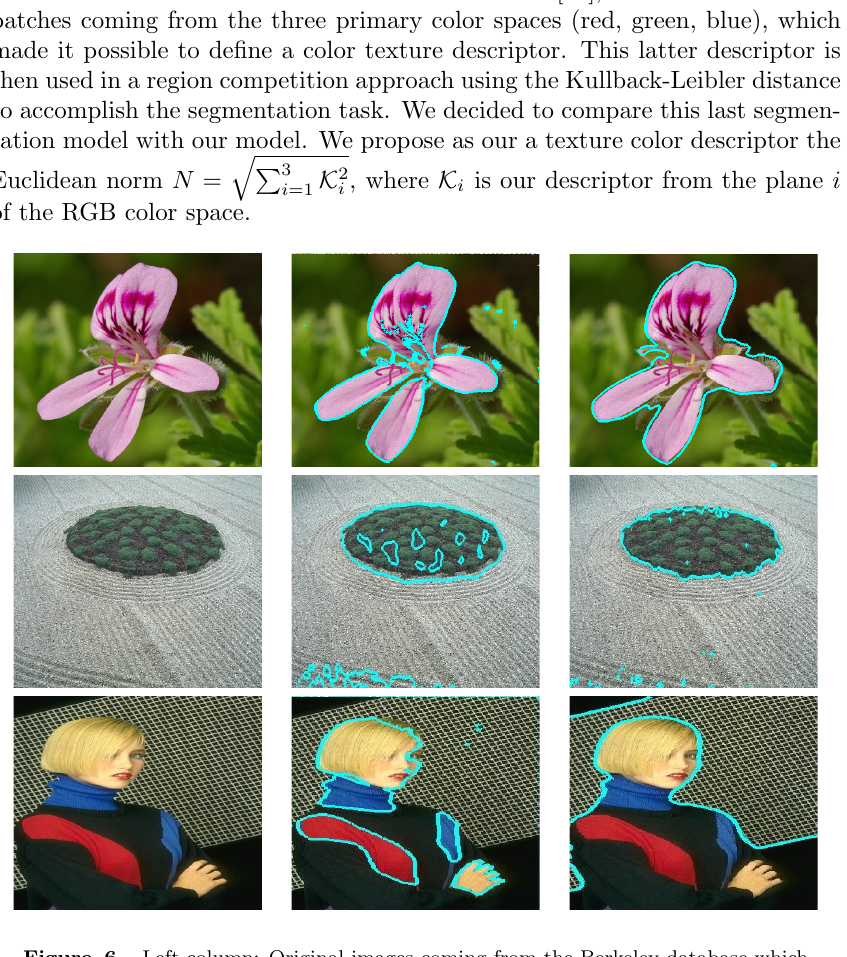
Figure 6. Left column: Original images coming from the Berkeley database which presents textured features. Central column: segmentation results obtained from the model in [24], right column: our segmentation